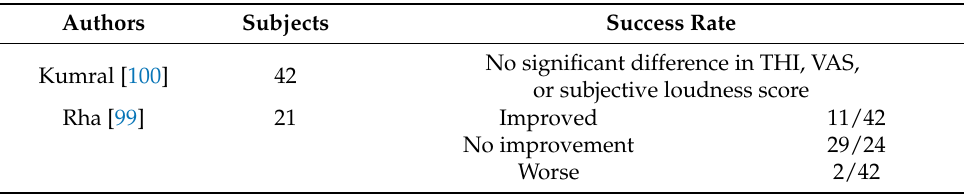
Table 14. Summary of studies that used trimetazidine to treat tinnitus.